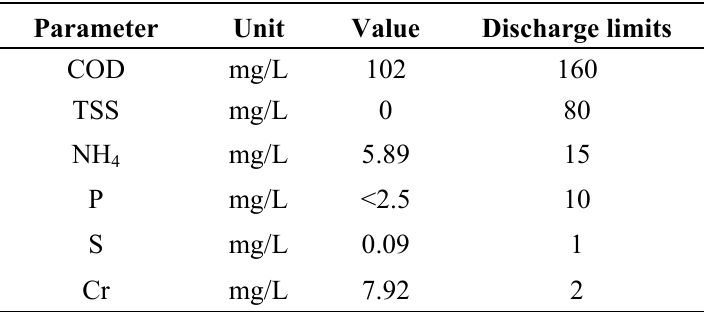
Table 4. Characteristics of the NF permeate.